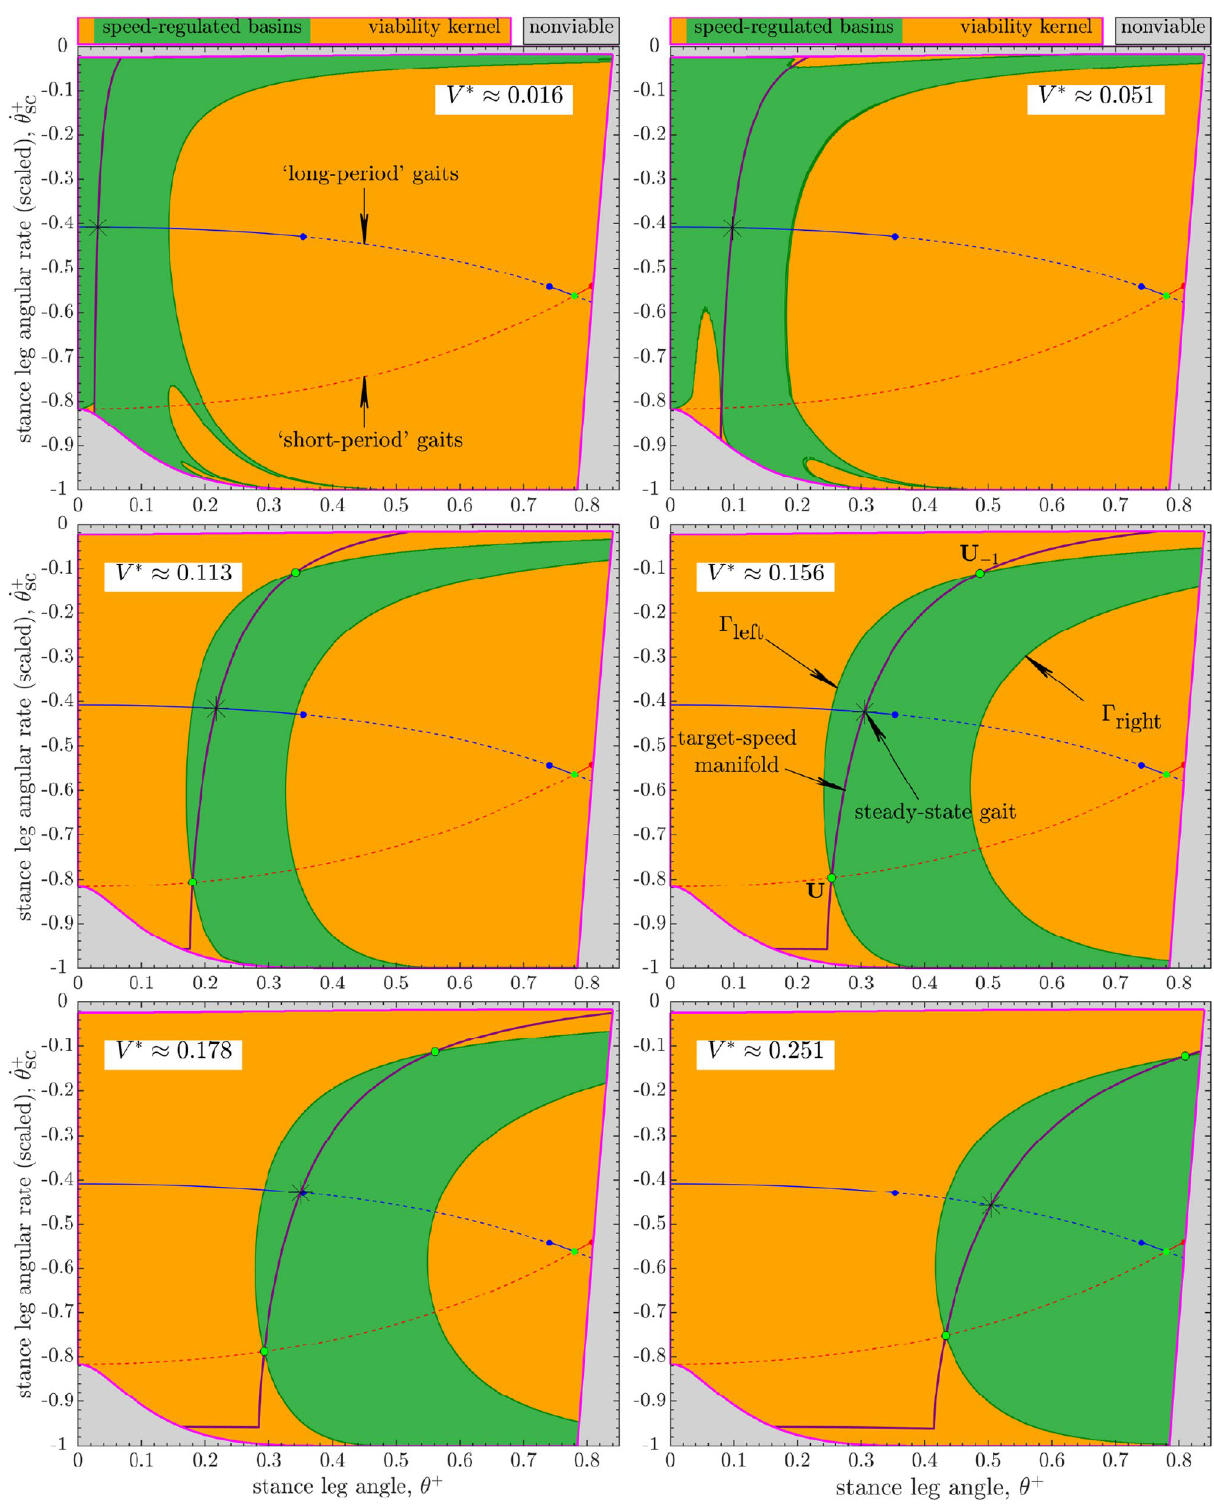
Figure 5. Evolution of the speed-regulated walker’s basin of attraction within the viability kernel V of its long-period steady-state gait ( ) with increasing target step speed V ∗ (or, push-off impulse P ∗ ∈ { 0.001, 0.01, 0.05, 0.1, 0.1325, ≈ 0.288 } ). Compare to Fig. 4. For V ∗ (cid:31) 0.113 , the basins are highly regular regions delimited by the level curves ( Ŵ left and/or Ŵ right of the form { θ − = constant } ) and the boundaries of V themselves. The geometric structure and size of the speed-regulated basins at V ∗ ∈ {≈ 0.016, ≈ 0.051 } is affected by viability constraints, specifically, actuation limits (Eq. 8): the basin at V ∗ ≈ 0.016 is similar in structure to the open-loop basin for P ∗ ∈ { 0, 0.001 } (Figs. 3 and 4). Basin areas ( % of the area of V ) for increasing V ∗ : { 8.12, 11.62, 20.59, 36.62, 44.83, 54.13 } %